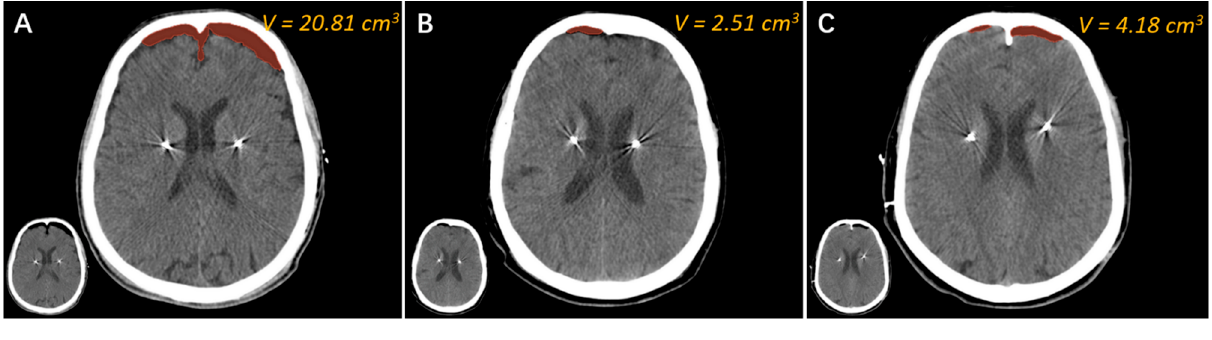
Figure 3. The comparison of three methods to reduce pneumocephalus and CSF loss. Representative intraoperative CT images of three patients who underwent bilateral electrode implantation, each with one of three burr hole-sealing approaches, are presented. ( A ) A 58-year-old male patient with Parkinson’s disease (PD) underwent bilateral STN-DBS electrode implantation in 2013. During the operation, bone wax was used to seal the burr hole. The air volume of the intraoperative CT images was 20.81 cm 3 . ( B ) A 65-year-old female patient with ET underwent bilateral Vim-DBS electrode implantation in 2021. The burr hole was filled with fibrin glue during the surgery. The air volume of the intraoperative CT images was 2.51 cm 3 . ( C ) A 60-year-old female patient with ET underwent bilateral Vim–PSA DBS electrode implantation in 2022. We adopted the “water sealing” method for this patient. The air volume of the intraoperative CT images was 4.18 cm 3 .